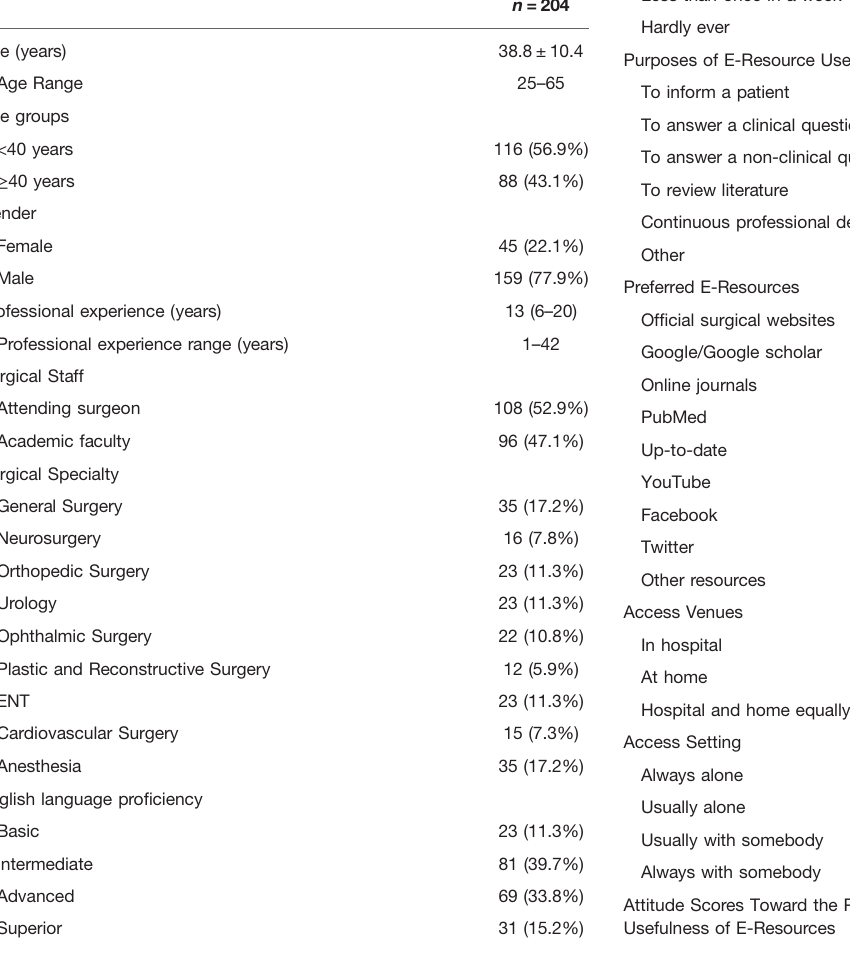
TABLE 1 | Demographic characteristics of participants.